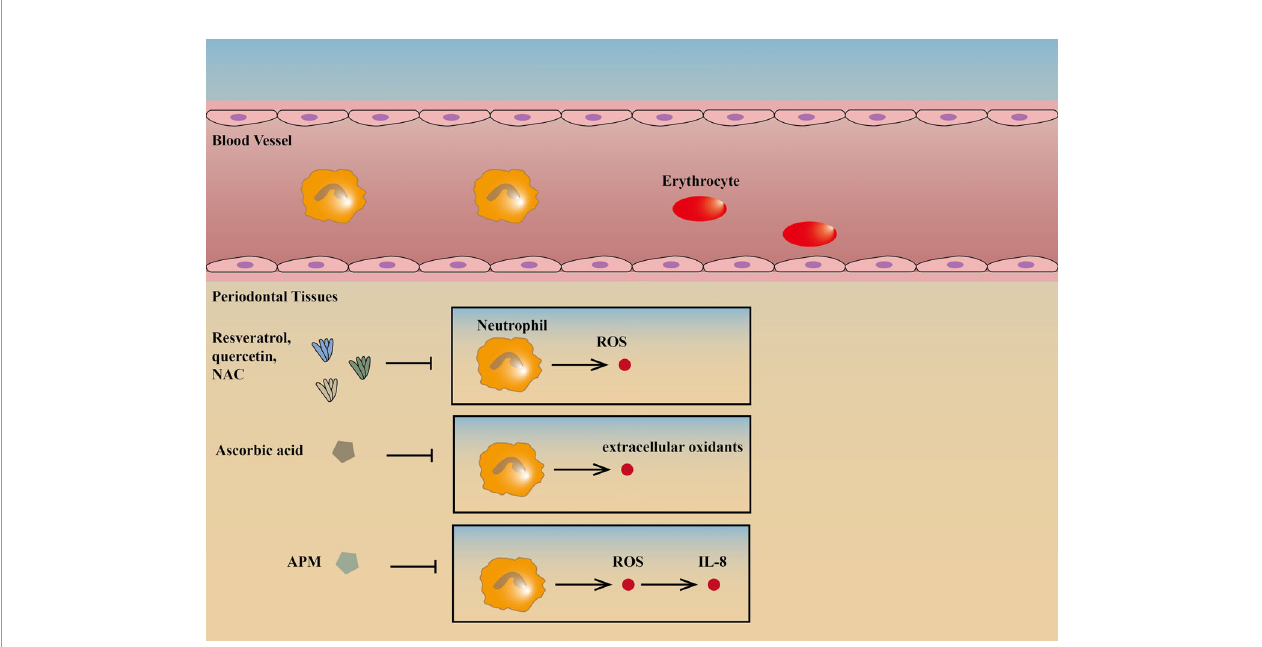
FIGURE 2 | Drugs targeting neutrophils. Resveratrol, quercetin, and NAC can reduce the production of ROS by neutrophils, therefore contributing to the integrity of gingival tissues and prevention of periodontitis (41). Ascorbic acid can reduce in fl ammation in patients with periodontitis possibly because it usually acts as a reducing agent and can be used to treat periodontitis by reducing the extracellular oxidants of neutrophils (42, 43). APM is effective in inhibiting IL-8 production and decreasing cell damage through the suppression of intracellular ROS (44). ↑ is a symbol for positive effects, and ↓ is a symbol for negative effects and the same goes for the fi gures and tables below. NAC, N-acetylcysteine; ROS, reactive oxygen species; APM, L-Ascorbic acid 2-phosphate magnesium